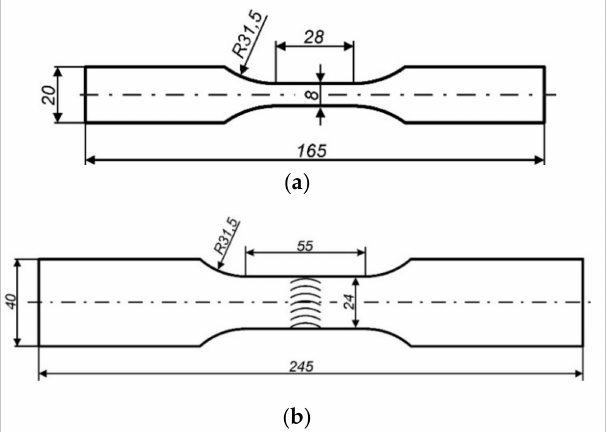
Figure 2. The dimensions of samples used during LCF tests of: ( a ) paternal material; ( b ) welded